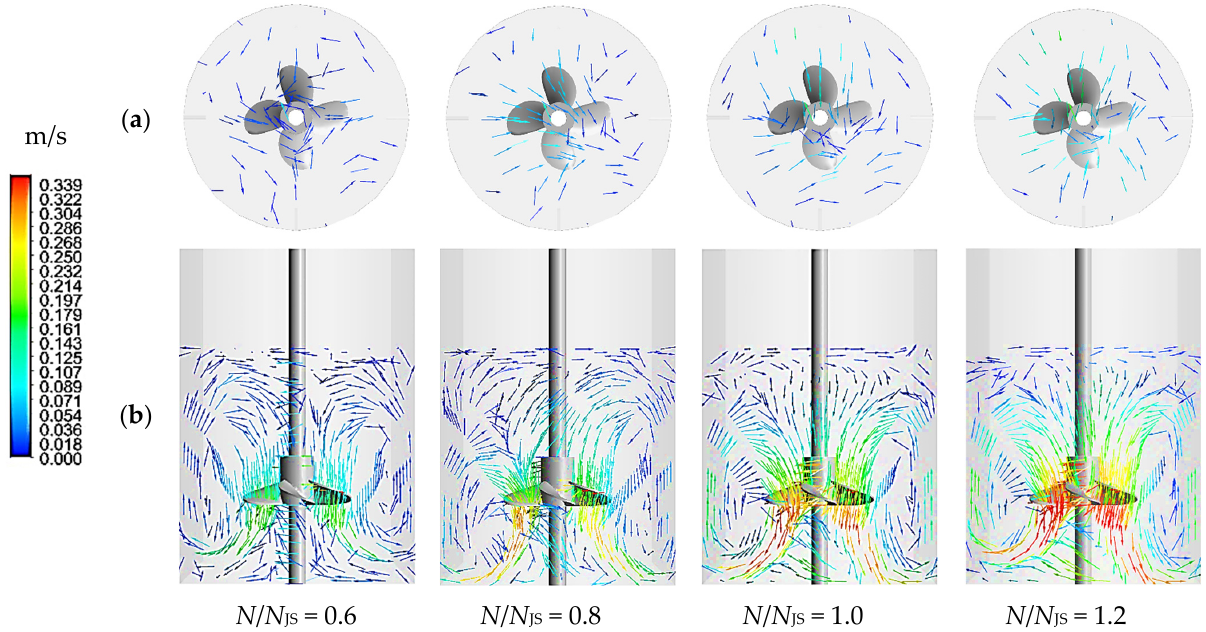
Figure 6. Vector plots and velocities in stationary frame contours in the reactor (top view at 0.12 suspension height ( a ) and side view ( b )) for four different N / N JS ratios. At N / N JS ratios above and below 1.0 the axial fluid flow pattern also formed. Veloci- ties are, as expected, the lowest for N / N JS = 0.6 and the highest for N / N JS = 1.2 (Figures 6 and 7). Consequently, at lower N / N JS ratios, zeolite particles are concentrated in the lower part of the reactor. An increase in the N / N JS ratio leads to an increase in the suspension height, i.e., the concentration gradient in the reaction mixture decreases. At N / N JS = 1, the maximum contact surface between the solution and zeolite particles is achieved, but there is still a difference in the distribution of zeolite concentration in the reactor. This difference decreases with an additional increase in the N / N JS ratio [30]. The fluid velocities near the bottom of the vessel are important for suspending settling particles. To suspend the par- ticles from the bottom, the velocities and turbulence levels near the bottom of the vessel must be high enough to incorporate the particles into the fluid mass [31]. At N / N JS = 0.6 (Figure 7a) these velocities are low and therefore a larger amount of zeolite particles are retained at the bottom while for N / N JS = 0.8 the velocities are higher, but still a small amount of zeolite remains at the bottom.